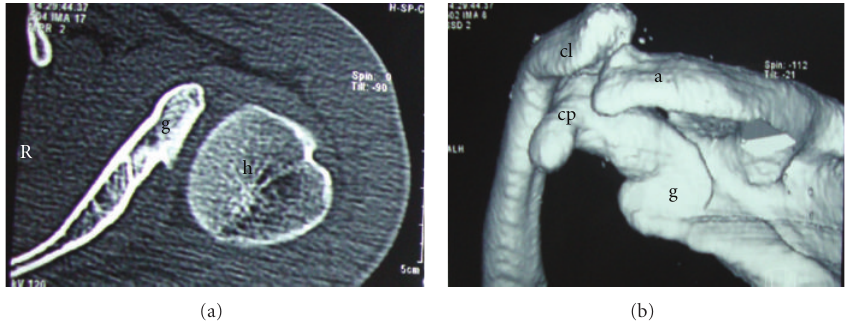
Figure 2: (a) CT scan showing (g) hypoplastic glenoid and (h) normal humeral head. (b) Three-dimensional CT scan showing (g) hypoplastic glenoid, (cp) prominent coracoid process, (cl) hooking of distal aspect of clavicle, and (a) prominent